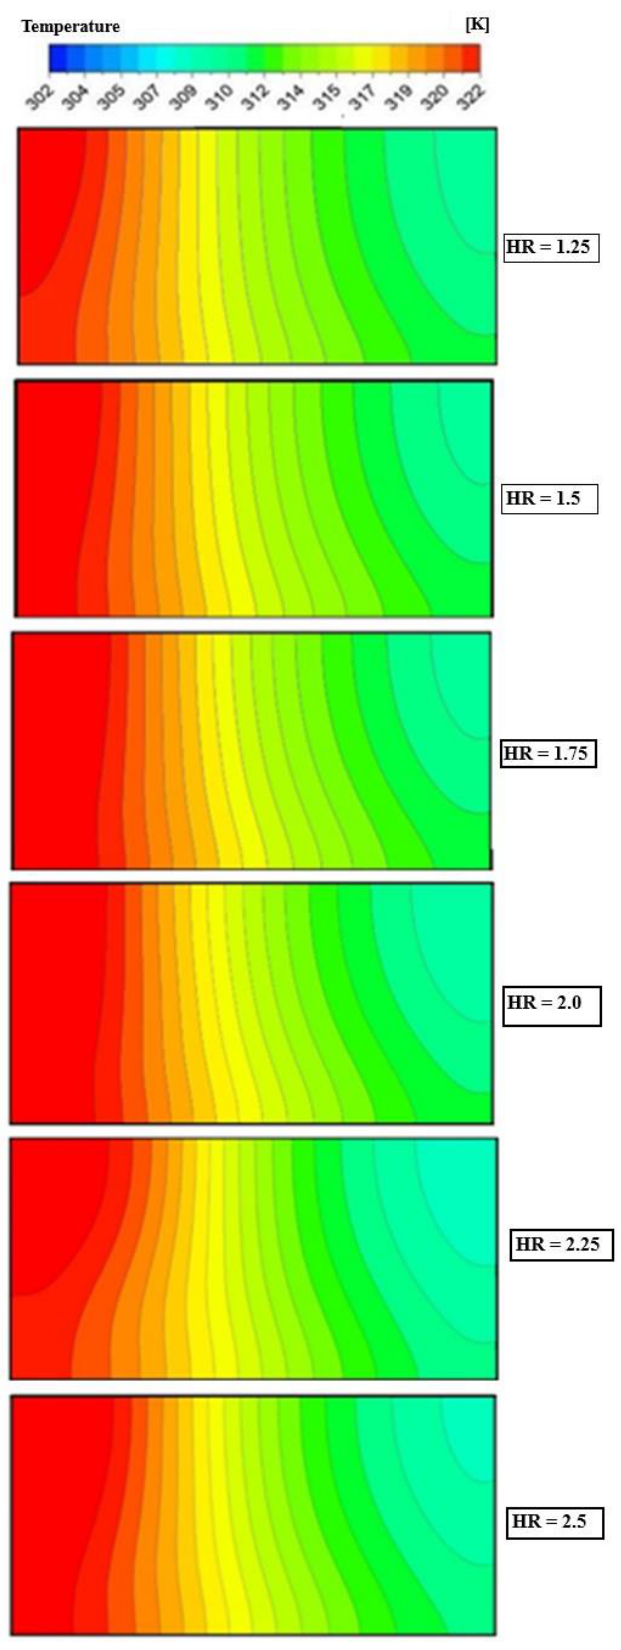
Figure 12. Temperature contours on the cavity bottom wall at different height ratios (1.25 ≤ HR ≤